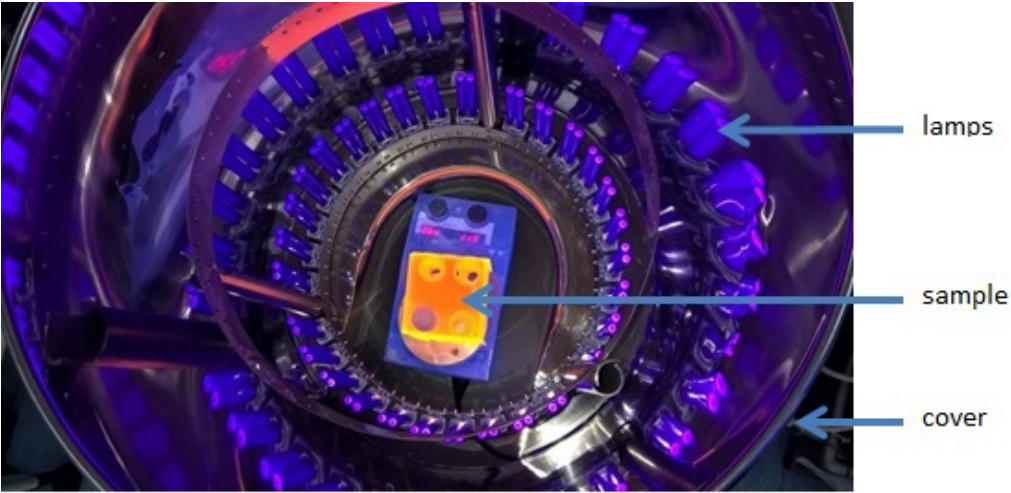
Figure 1. The interior of a photoreactor constructed by our team.